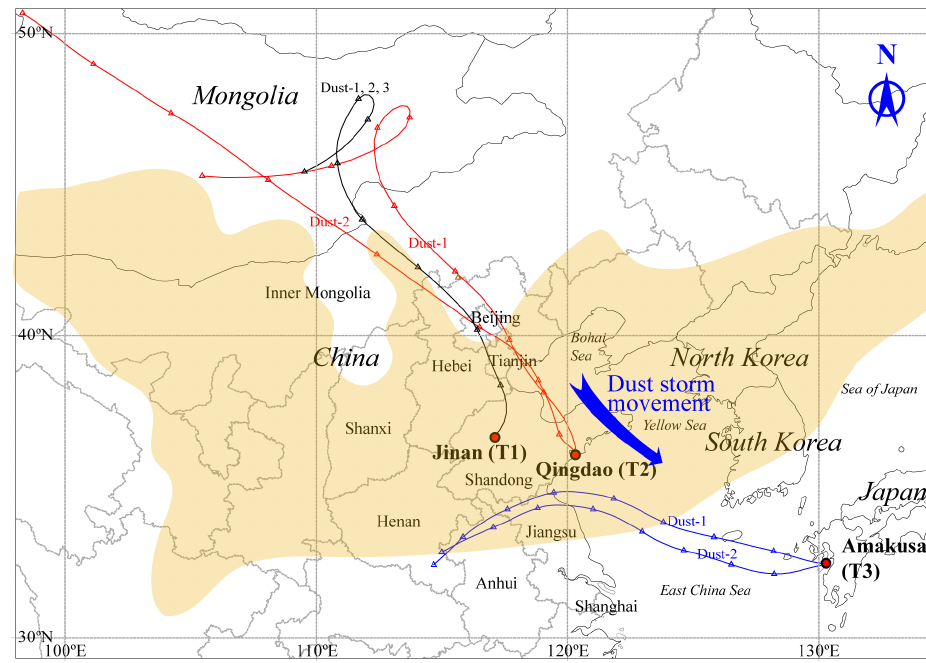
Figure 1. The locations of the three sampling sites and HYSPLIT (HYbrid Single-Particle Lagrangian Integrated Trajectory) 48h air mass backward trajectories arriving at 1500 m above ground level at T1, T2, and T3 sites. The interval between two triangle symbols is 6h. The yellow shadow is derived from Fig. S1, which represents the area influenced by the dust storm at 00:00UTC on 18 March